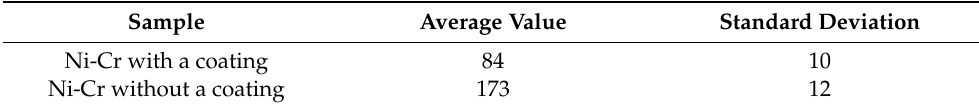
Figure 7. Sample surfaces with adhering bacteria ( a ) Ni-Cr alloy sample without a coating. ( b ) Ni-Cr alloy sample with a carbon layer. Table 4. The number of bacteria adhering to the surfaces (150 × 100 µ m) of the particular groups of samples.